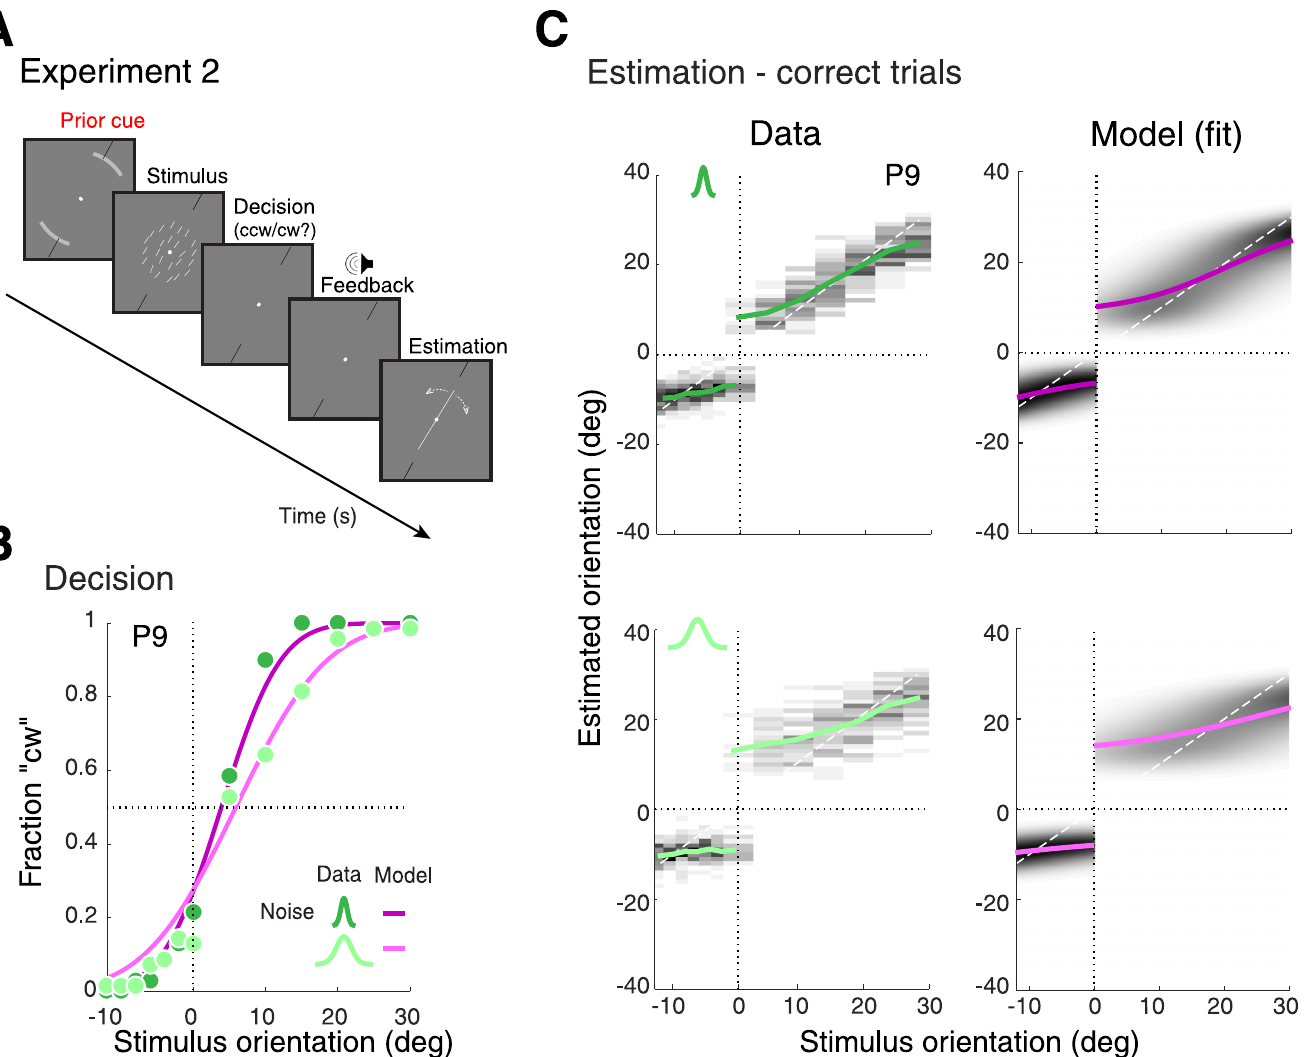
Fig 6. Experiment 2—Data and model fits for correct trials. (A) Experiment 2 was identical to Experiment 1 except that the stimulus range was asymmetric around the reference ([-12, 30] deg, positive values indicating cw orientations relative to the reference). Subjects were reminded about the asymmetry at the beginning of each trial by explicitly showing the actual stimulus range (gray arcs). Stimulus noise levels corresponded to two different widths of the stimulus array distribution ( σ s ≔ {6, 18} deg). (B) Psychometric functions representing subjects’ categorical choice behavior (typical subject P9). Green circles indicate the data and purple lines indicate the fit with the self-consistent observer model. Darker colors represent conditions with lower stimulus noise. Note that the subjects’ decision probability of choosing cw is smaller than 0.5 for stimuli at the reference orientation. This matches the prediction of an optimal decision-maker given the asymmetric stimulus range even with equal prior probability for each category. When fitting, we allowed the category prior probability to be a free model parameter although fit values were close to 0.5 (see Fig 7A). (C) Measured estimate distributions and the predictions of the fit self-consistent model for correct trials only (colored lines: mean). Estimates on the ccw side are closer to the reference and less repulsed. This is well captured by the model and thus can be explained as the effect of the asymmetric prior in the inference process. See S3 Fig for data and model fits of all other subjects.